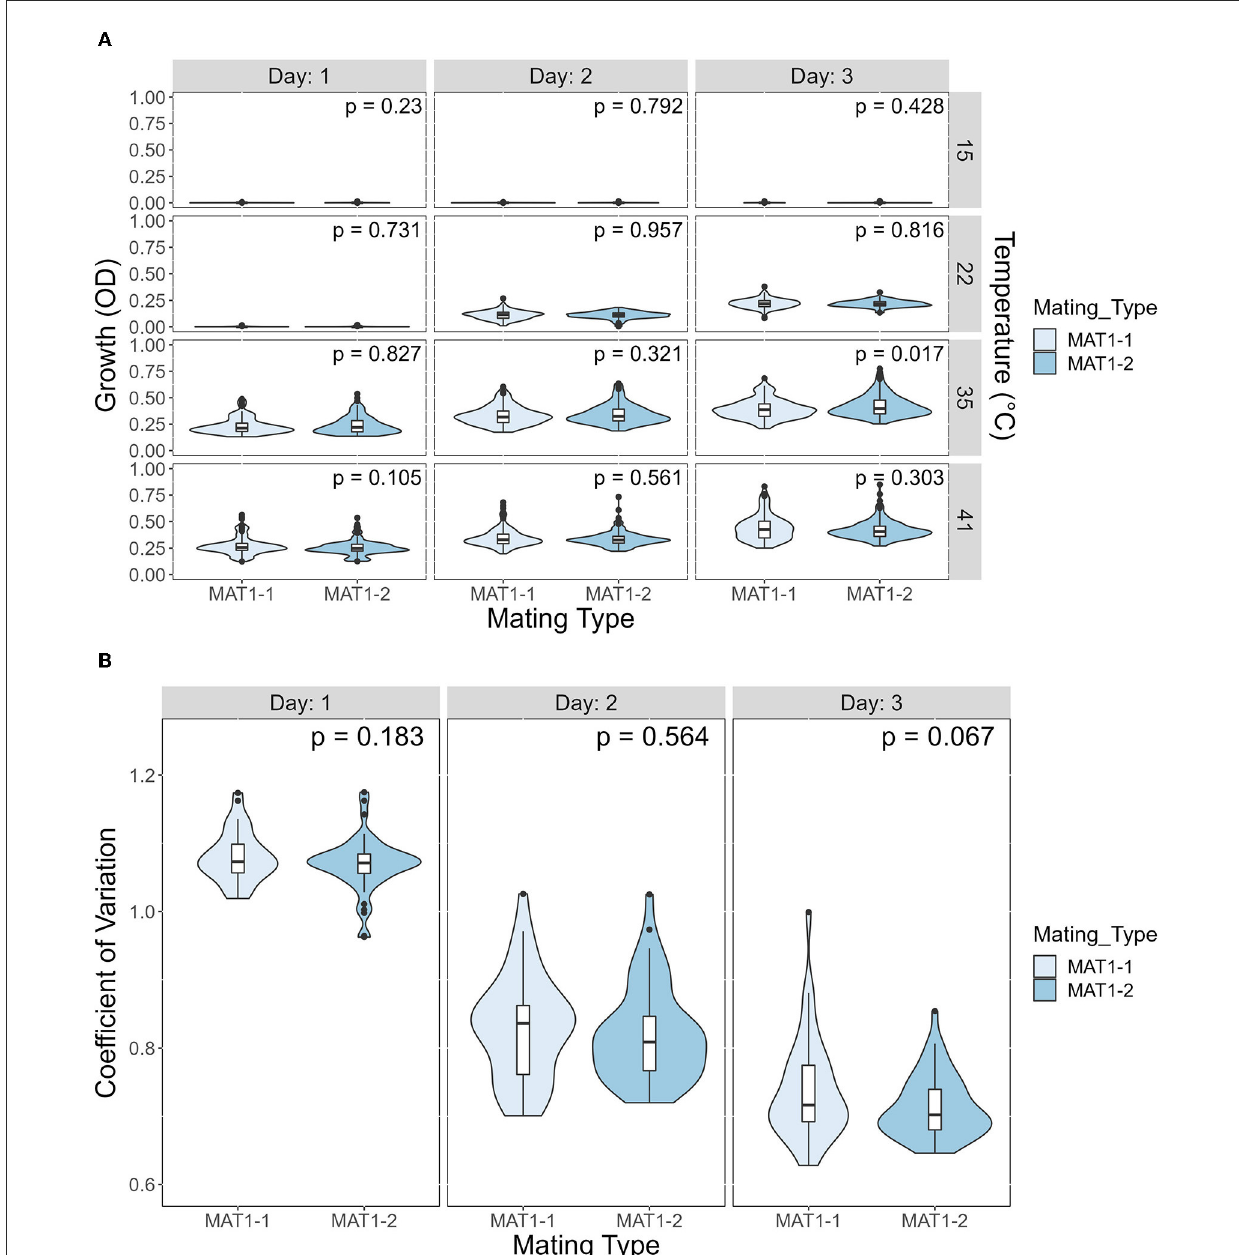
FIGURE8 The mating type of A. fumigatus strains has a minimal contribution to growth difference and to coefficient of variation (CV). (A) Violin plot showing difference in growth between MAT1-1 and MAT1-2 at each temperature on each day. Significance was determined through Mann-Whitney test. (B) Violin plot showing difference in CV between MAT1-1 and MAT1-2 at each day. Significance was determined through Student’s